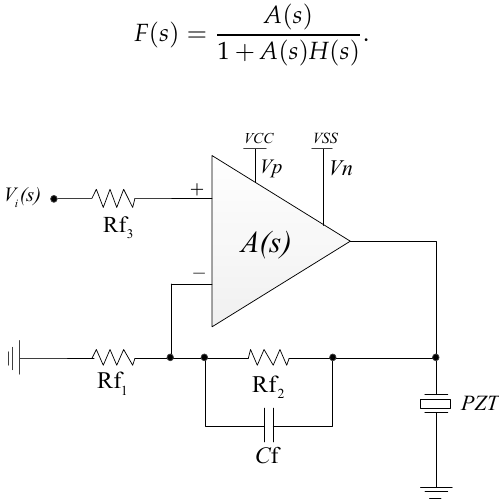
Figure 6. The noninverting amplifier is used as a power amplifier.